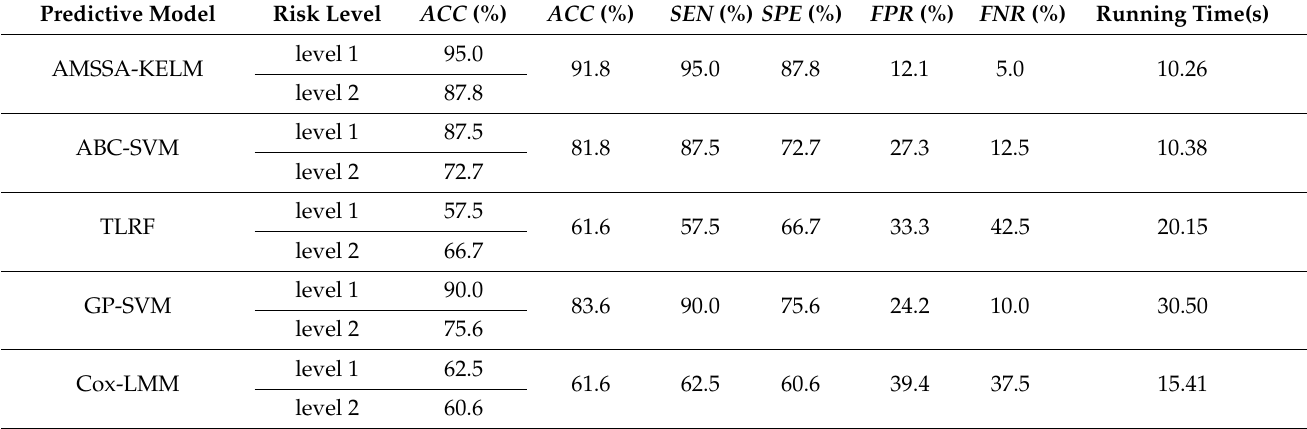
Table 5. The prediction results of different prediction models. SEN : Number of correct and positive validation predictions, as a percentage of positive numbers. SPE : The number of predictions that are negative and correct, as a percentage of the actual total number of negative purposes. FPR : False-positive rate. FNR : False-negative